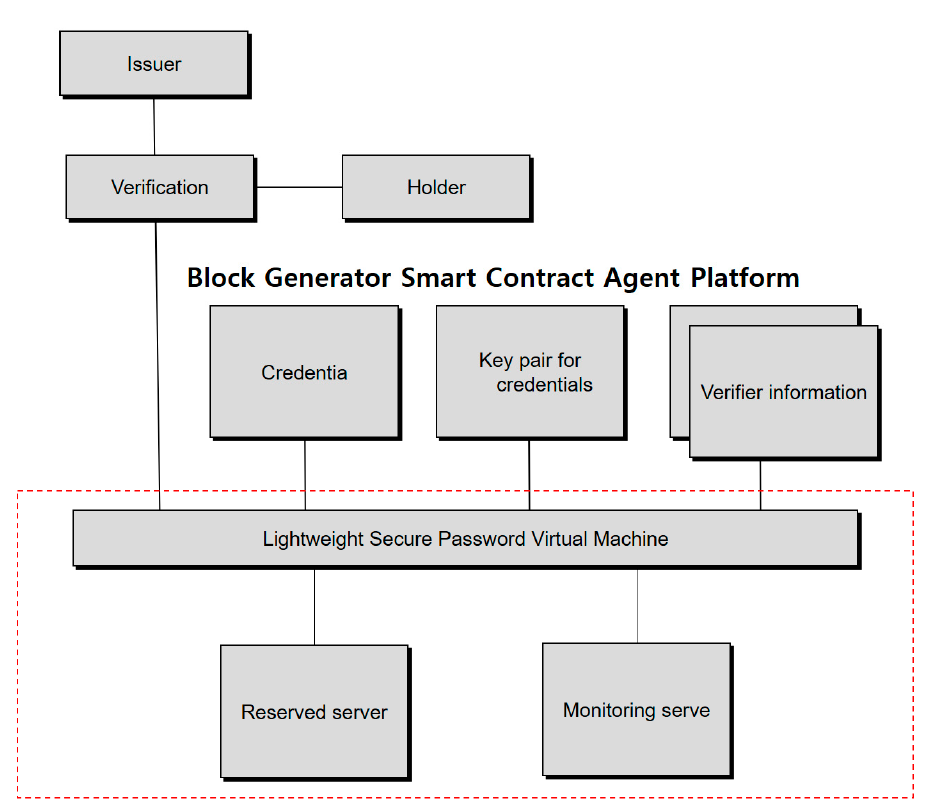
Figure 5. Block generator smart contract agent platform.